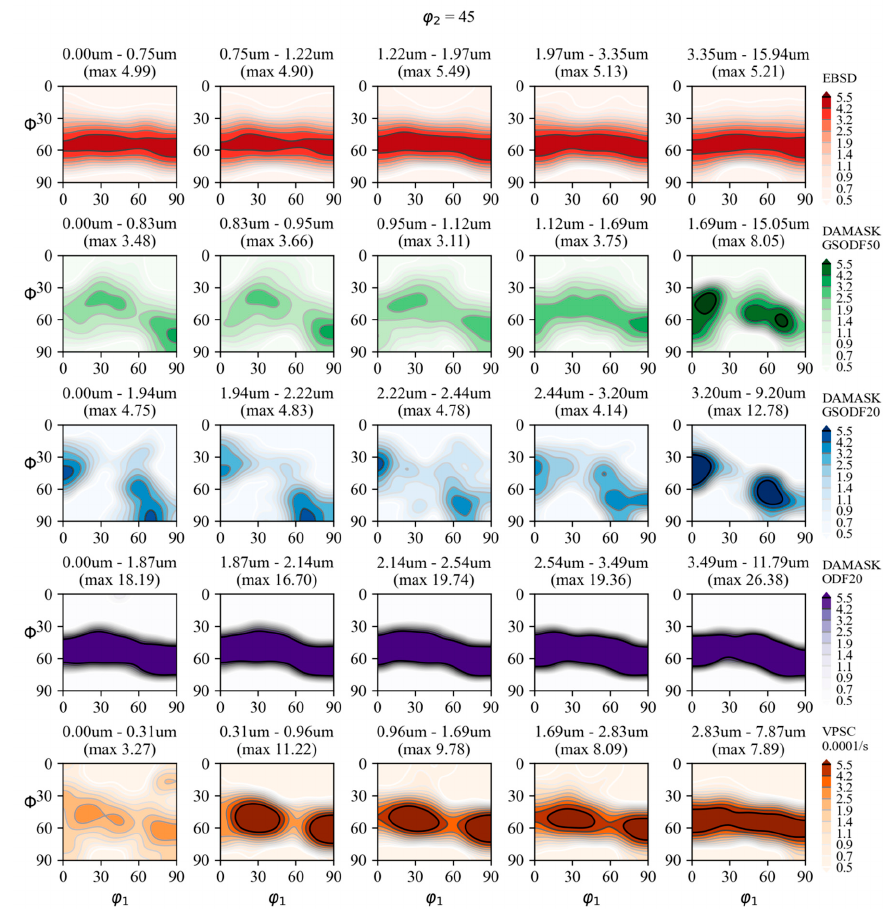
Figure 14. Grain size dependent ODFs (deformation: 15%) obtained from the EBSD measurements, the DAMASK simulations with the GSODF50, GSODF20 and ODF20 RVEs, and the VPSC simulation at a strain rate of 0.0001/s.